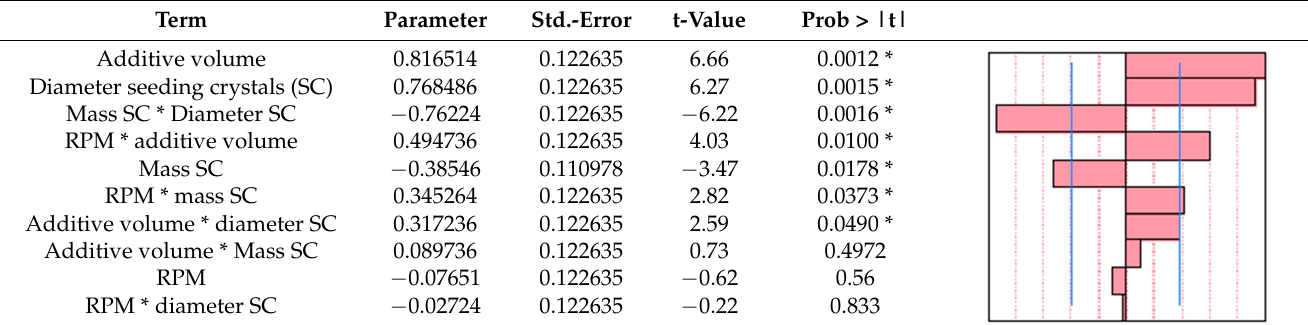
Table 2. Parameter influence on the crystal size distribution. The terms marked with a star (*) are statistically significant. Term